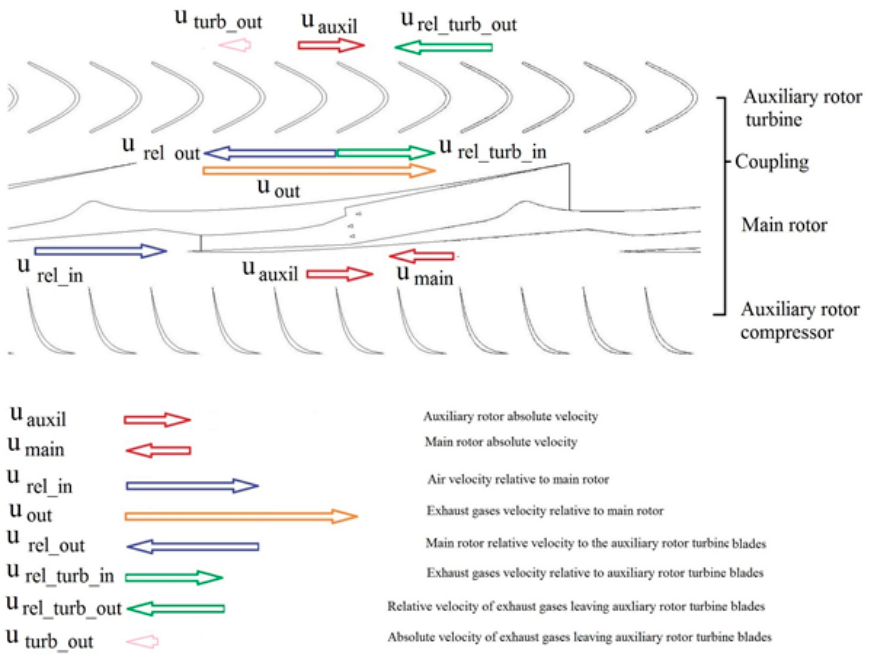
Figure 3. Contra-rotary ramjet engine idea and features.